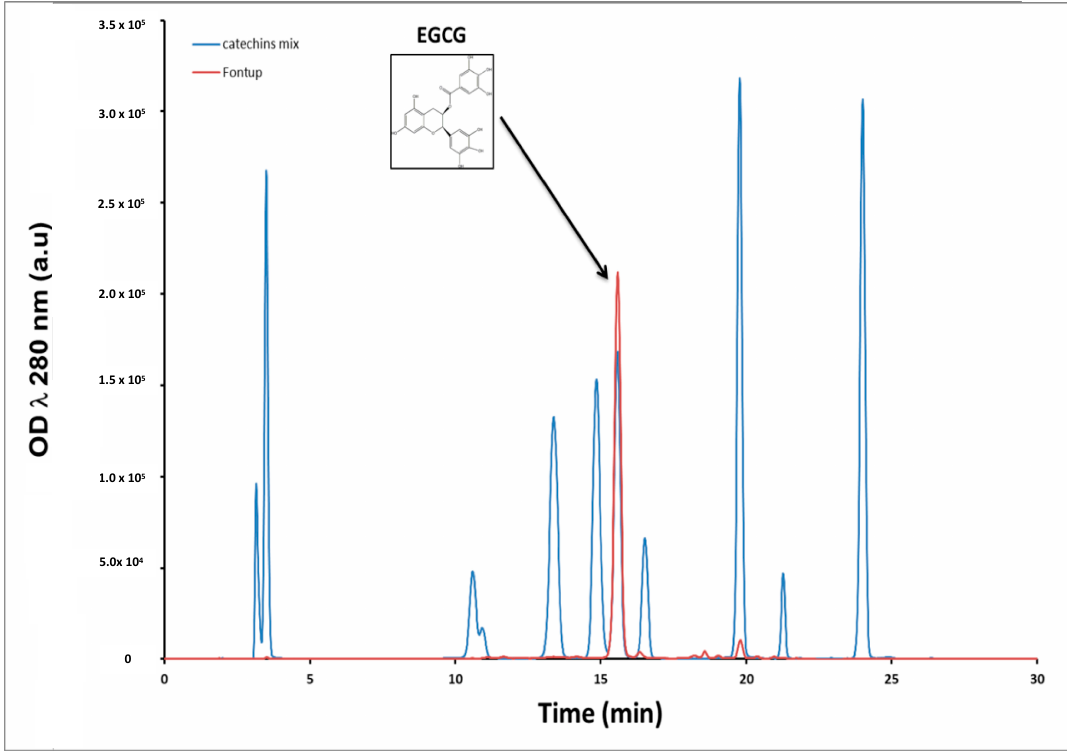
Figure 1. Chromatogram of the FontUp ® solution.